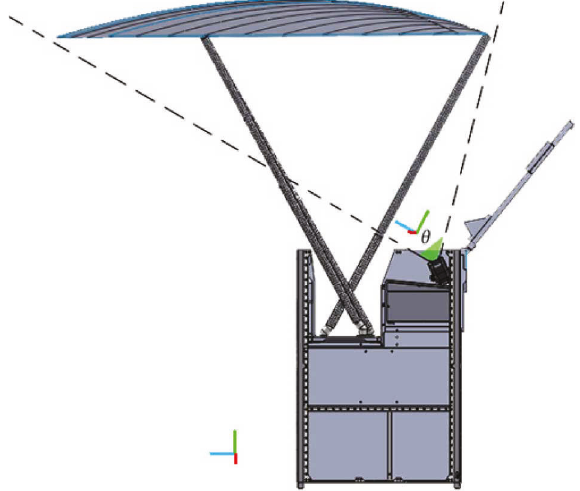
Figure 2: The camera location on-board; here, θ is the fi eld of view which will be considered as ∈ [60, 90]. Note the di ff erence between the coordinate systems of each satellite and camera.